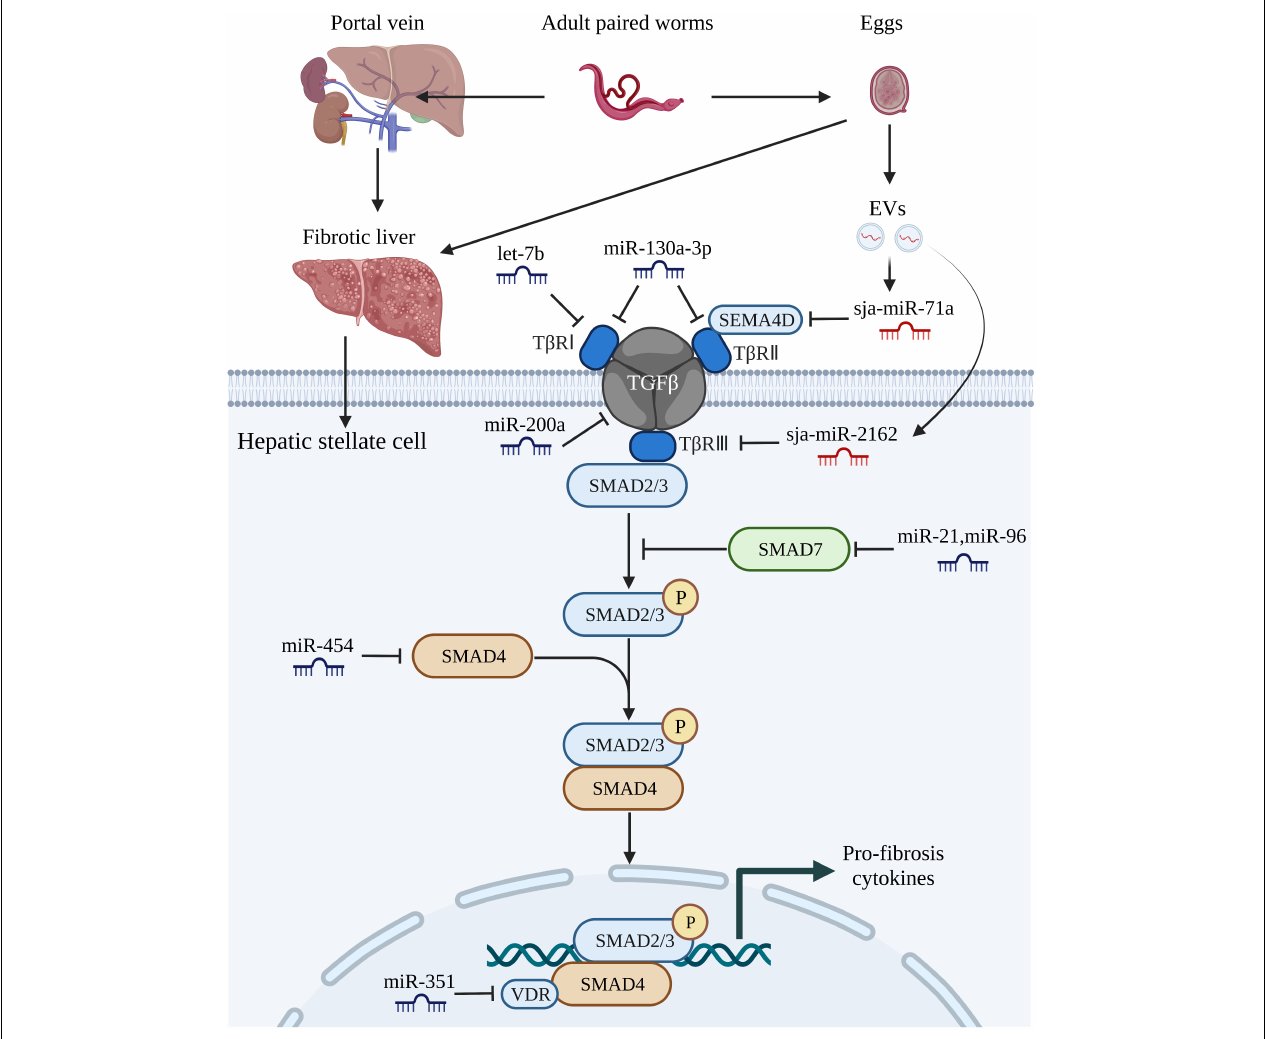
FIGURE 2 | MiRNAs regulate schistosome-induced liver fibrosis through TGF- β /SMAD signaling pathway. The adult paired worms migrate to the portal vein and lay eggs. TGF- β /SMAD signaling pathway, one of the most critical signaling pathways that associated with liver fibrosis in hepatic stellate cells, can be activated by soluble egg antigen TGF- β /SMAD signaling pathway. TGF- β binds to the receptors (T β RI, T β RII, T β RIII) leading to phosphorylation of Smad-2 and Smad-3, followed by aggregation with Smad-4 and subsequently drives the expression of Smad-7 which negatively regulates TGF- β /SMAD signaling pathway. Both